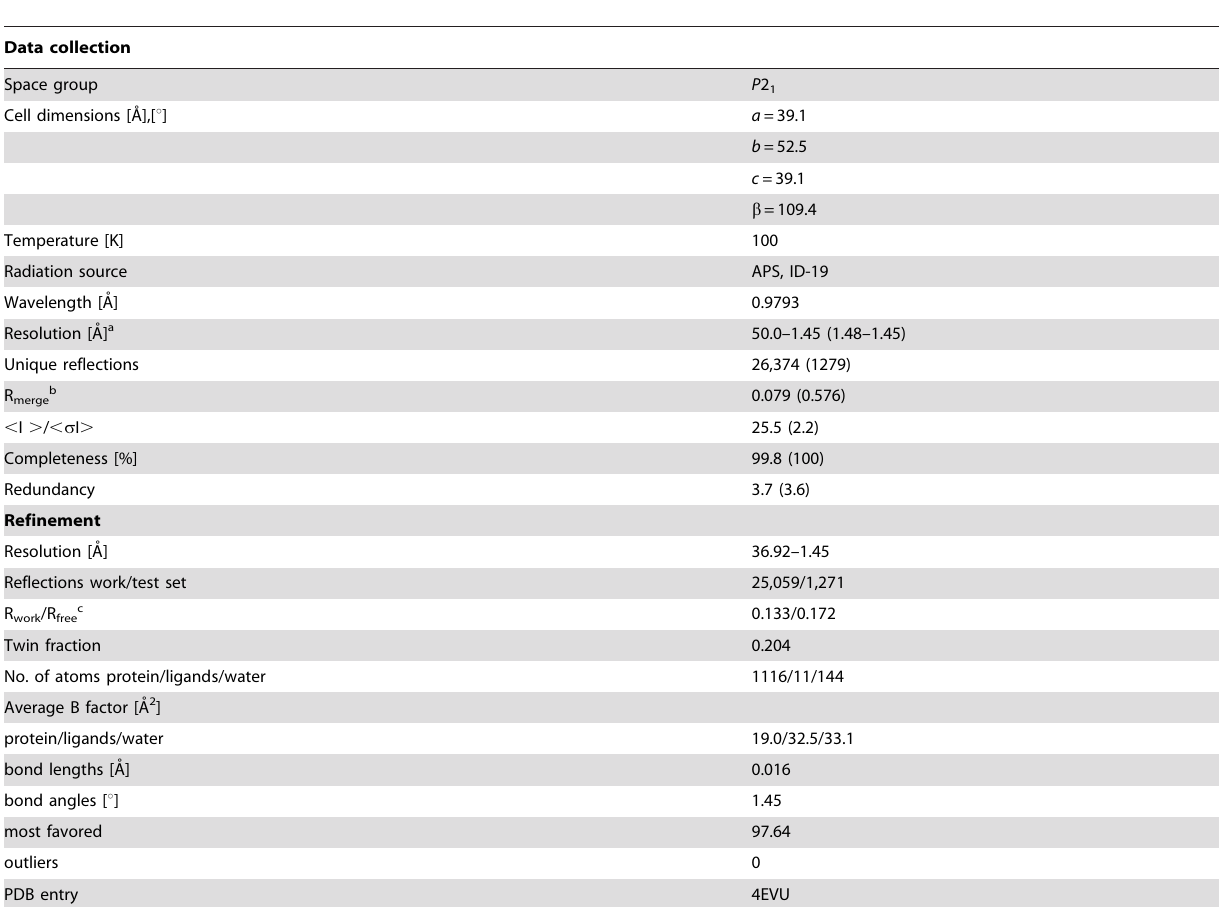
Table 2. X-ray data collection and refinement statistics for